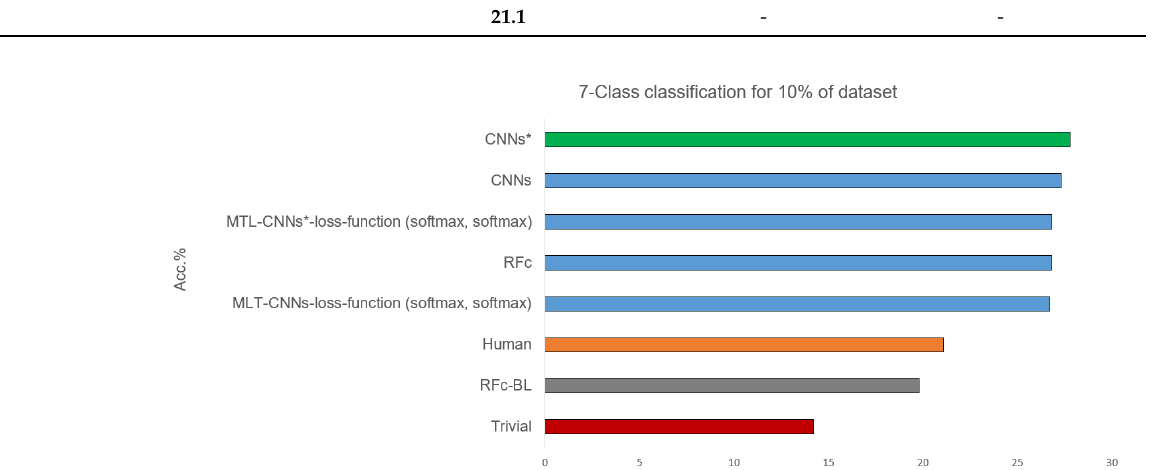
Figure 6. Best recognition models for 7-class classification task compared to baseline and trivial model and human observation using 10% of